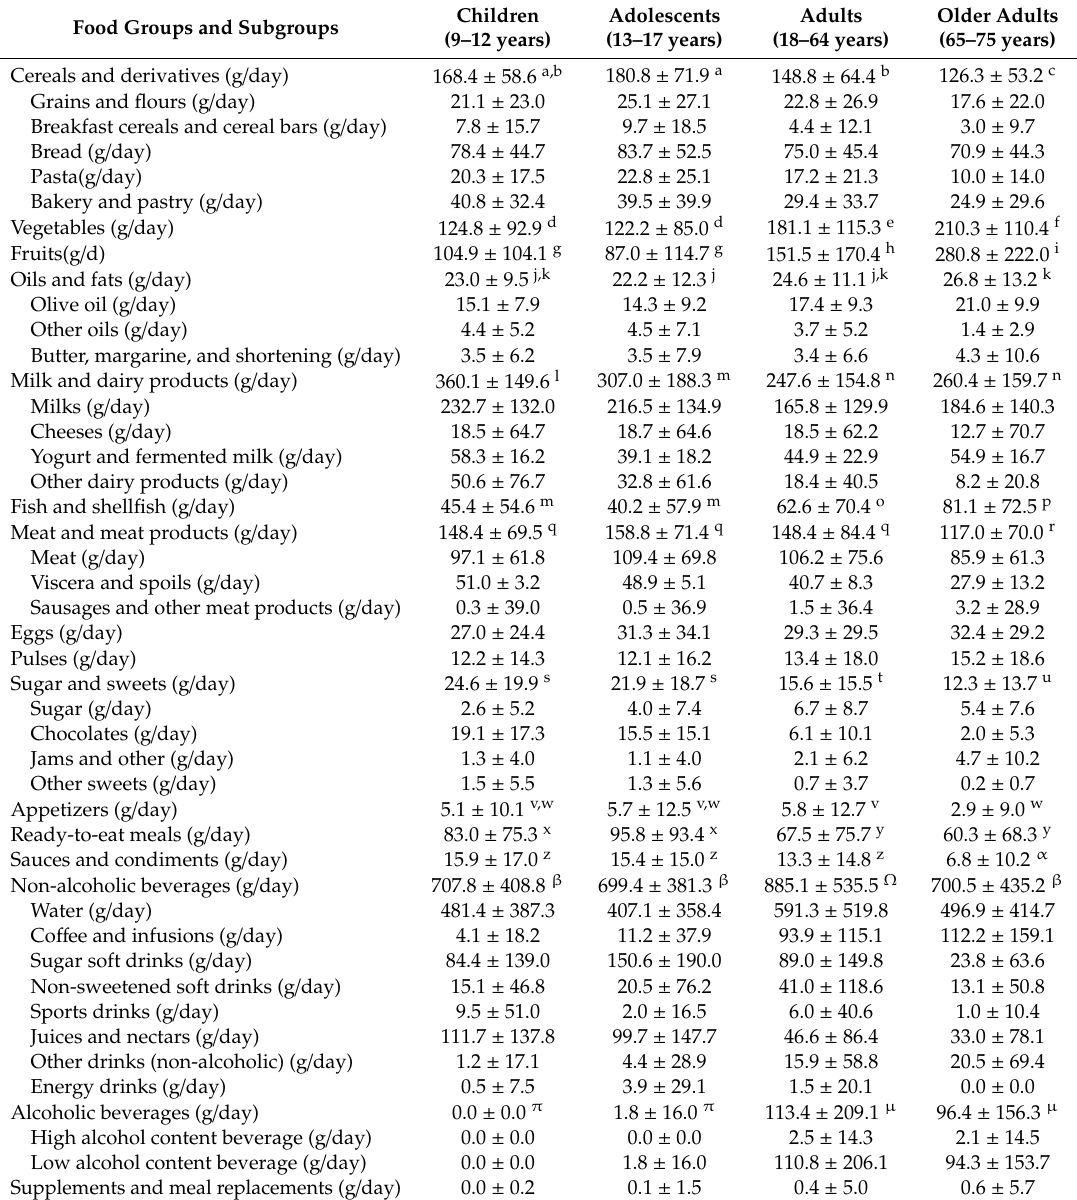
Table 3. Total daily food groups and subgroups intake by age amongst the Spanish ANIBES study